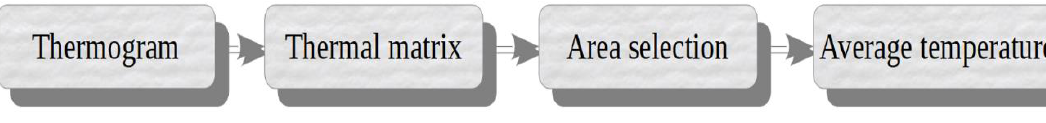
Figure 6. Thermal biomarker acquisition methodology.